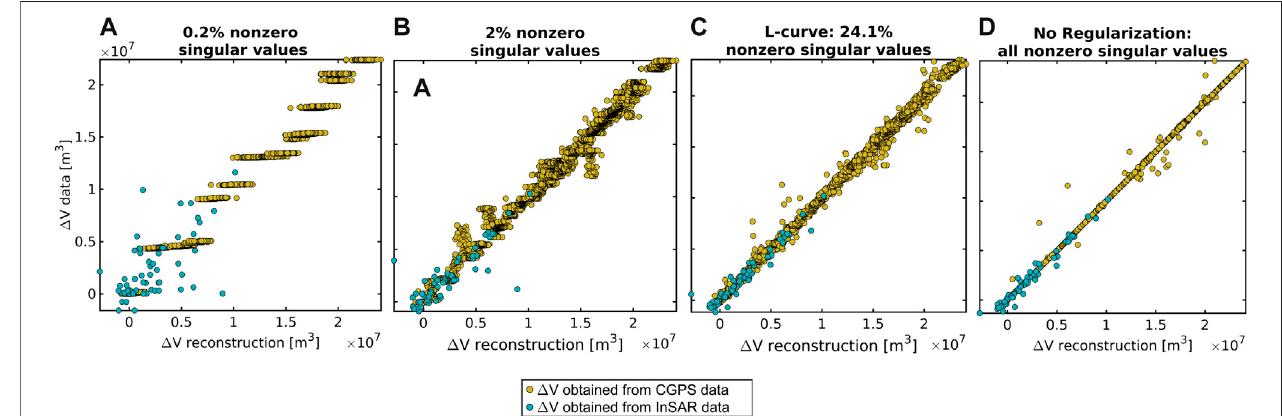
(cid:1) V ( − V i + 1 ) i , reconstruction